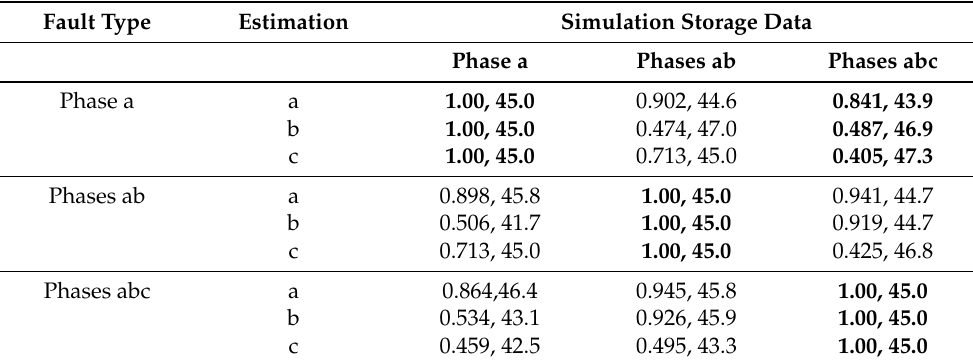
Figure 14. CCvs as a function of the GFL ( x g ): a fault is considered in Phase “a” at 45 km and esti- mated in all three phases, while the correlation of the H fos and H fes of the 3-phase fault type scenario is shown. Table 3. Test fault location of 45 km having different fault types scenarios and its estimation (CCv, x g ) in each phase by the pseudo